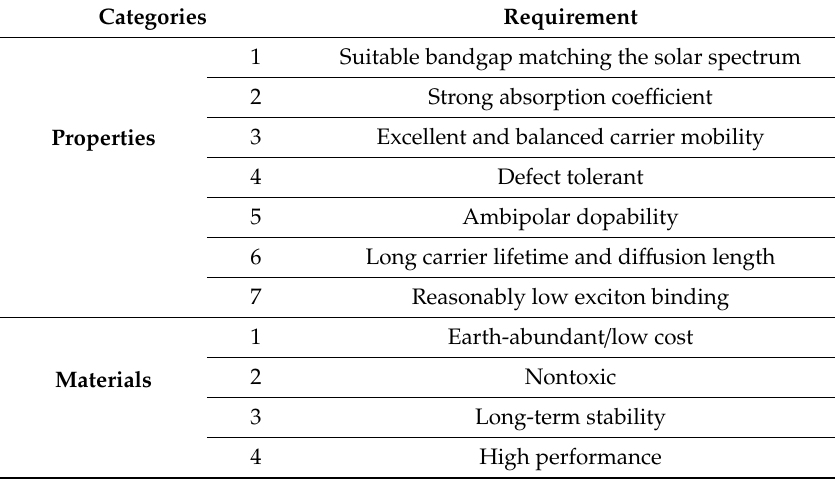
Table 1. Summarized requirements for the best-performance photovoltaic (PV) applications in terms of materials and properties